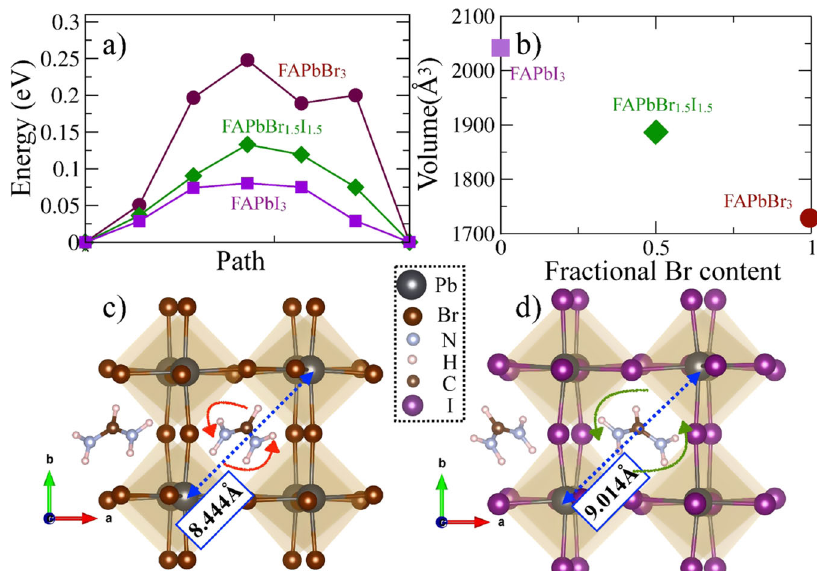
Fig. 4 Role of the central organic moiety in the observed phonon dynamics. a Calculated minimum-energy path for the rotation of FA moiety between two stable symmetrically equivalent con fi gurations. The results are shown for FAPbBr 3 (maroon circle), FAPbBr 1.5 I 1.5 (green diamond), and FAPbI 3 (purple square). b Change in volume of the 2 × 2 × 2 supercell (used for our DFT calculation) as a function of Br fraction. c , d show the relaxed structures of FAPbBr 3 and FAPbI 3 , respectively. The numbers indicate the framework cage